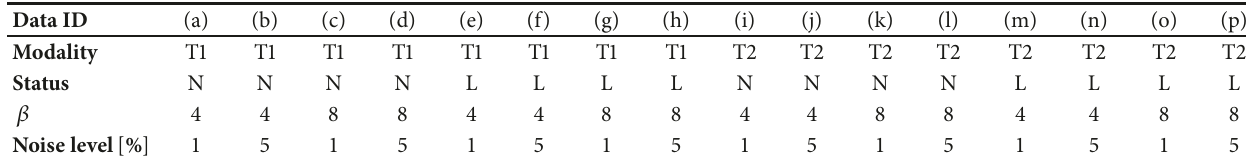
Table 1: Correspondences of simulational settings and image indices. N/L of the Status row means the normal/lesional brain. Data ID is used to index in Figures 6-7 and in Supplementary Material S7.